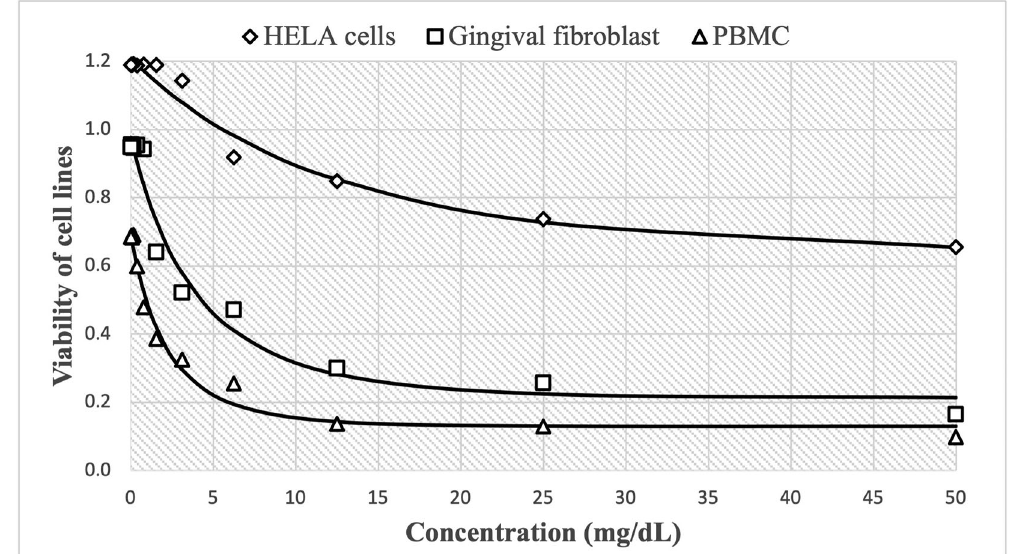
Figure 2. Viability of cell lines by the effect of concentrations of ethanolic extracts of P. guajava. The cytotoxic effect of guajava is shown in Figure 2, with high cell viability at concentrations of 0.24 mg/mL, reaching 1.190 (cid:4) 0.015 Henrietta Lacks cells (HELA cells), 0.948 (cid:4) 0.020 human gingival fibroblasts (HGF-1) and 0.685 (cid:4) 0.019 peripheral blood mononuclear cells (PBMCs cells). These decreased more slowly to 0.656 (cid:4) 0.019, 0.165 (cid:4) 0.020 and 0.099 (cid:4) 0.002, respectively as concentrations increase up to 50 mg/mL. Similarly, the observed trend shows that cell growth decreases in a non-linear fashion as the dose of guajava administered increases.